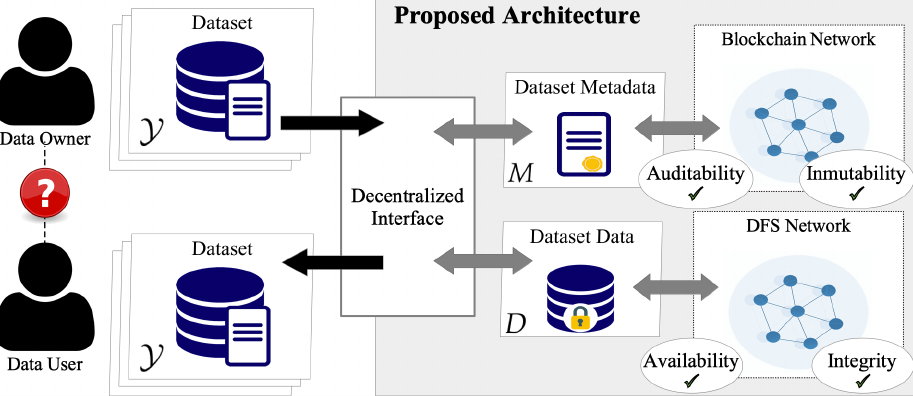
Figure 3. Block scheme of the proposed system architecture that provides an infrastructure for sharing datasets among untrusted